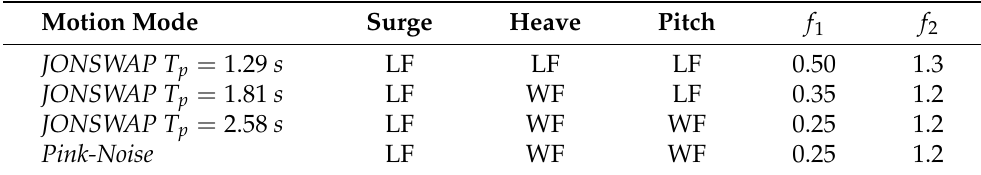
Table 3. Expected resonance responses for irregular wave conditions (low frequency (LF) or wave frequency (WF)) and WF range [ f 1 , f 2 ] (Hz) per wave